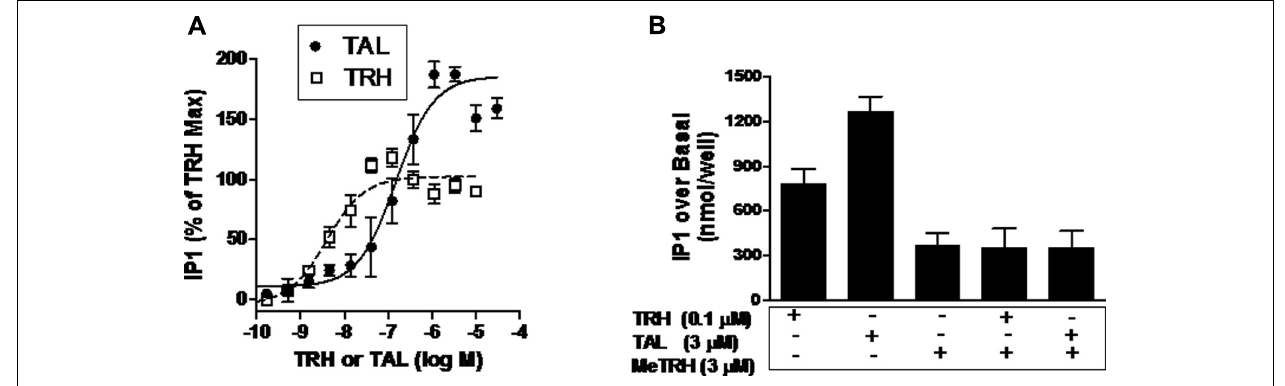
FIGURE 3 |TAL is a superagonist atTRH-R. (A) IP1 production was determined in HEK 293 cells expressingTRH-R in the presence of increasing doses ofTAL orTRH as described in Section “Materials and Methods.”The data represent the mean of duplicate points from five experiments.